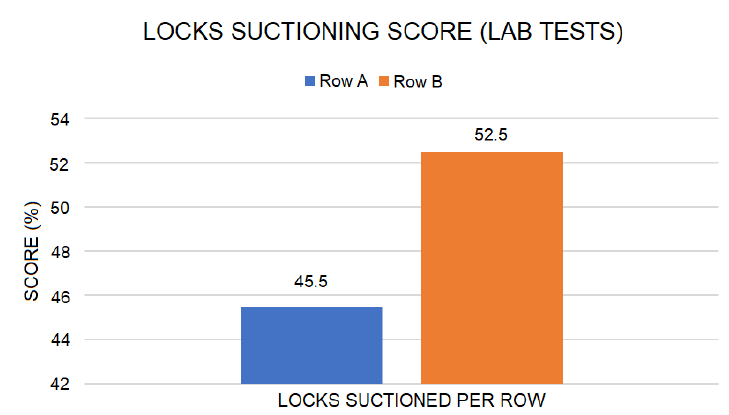
Figure 17. Percentage of locks successfully suctioned per sampled row.